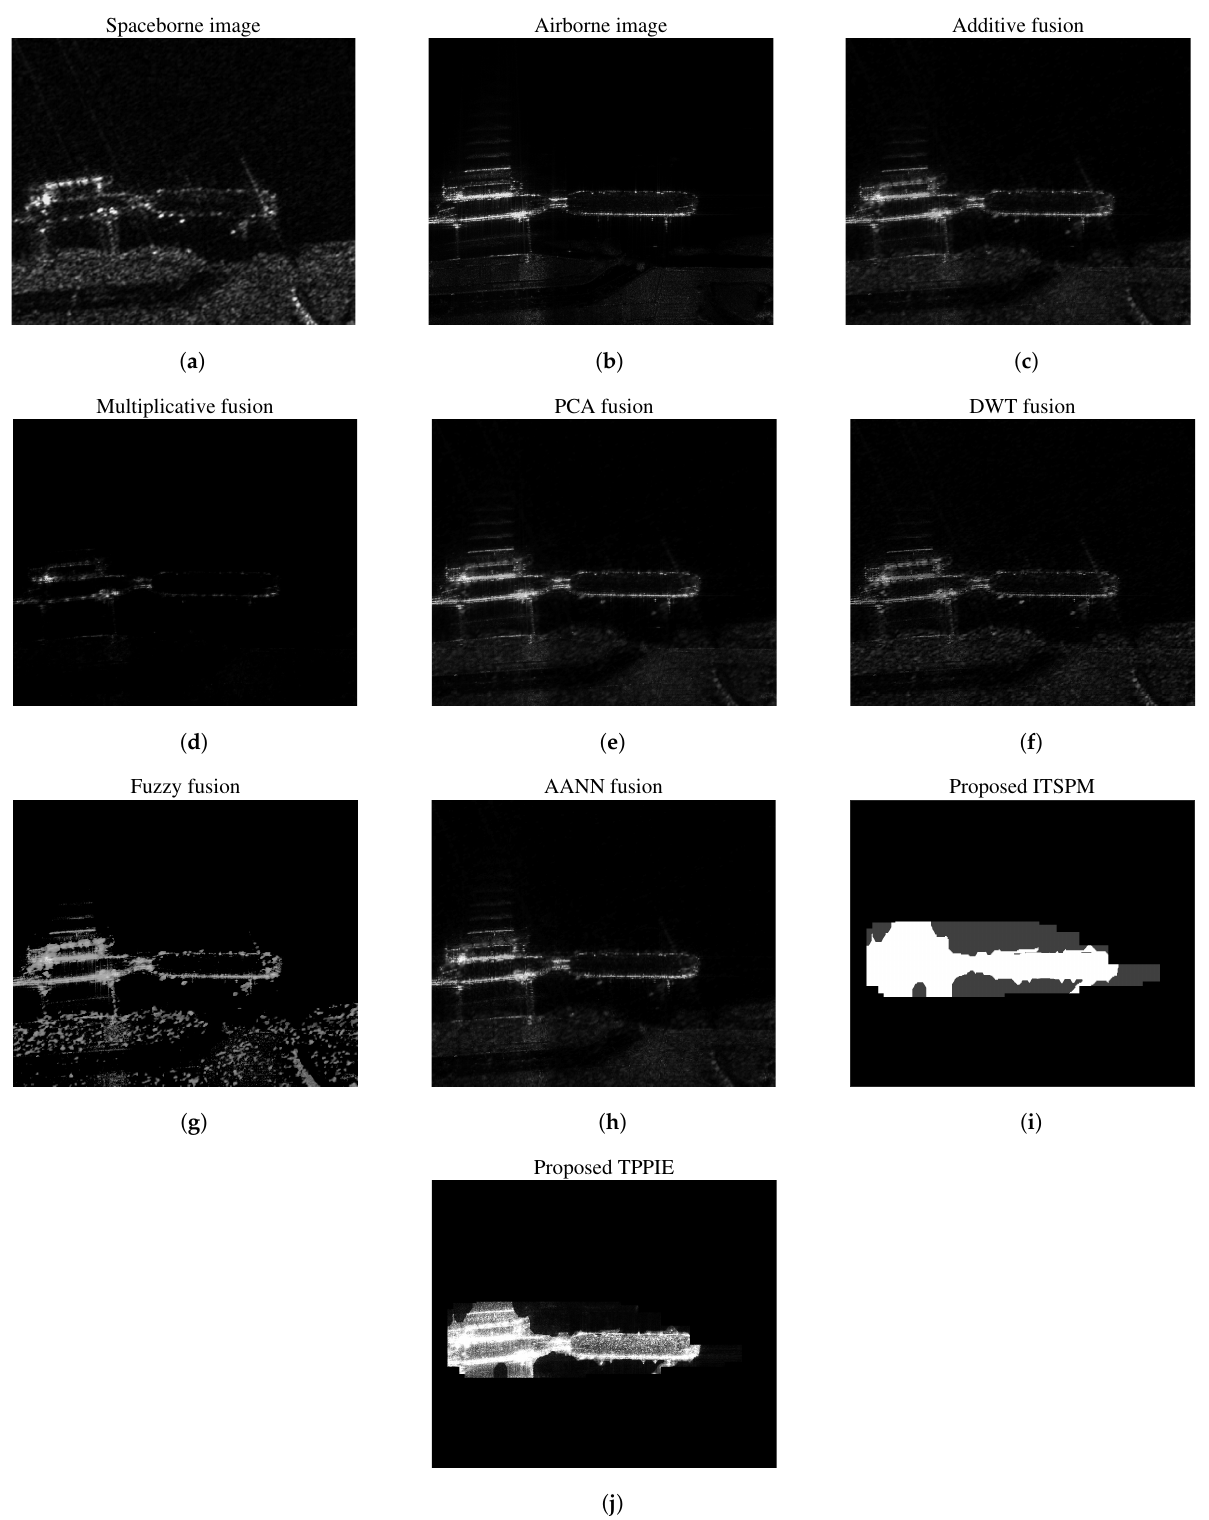
Figure 6. Experimental results for scene 1: ( a ) Spaceborne image; ( b ) airborne image; ( c ) additive fusion [10]; ( d ) multiplica- tive fusion [10]; ( e ) PCA fusion [12]; ( f ) DWT fusion [13]; ( g ) fuzzy fusion [16]; ( h ) AANN fusion [18]; ( i ) proposed ITSPM fusion; and ( j ) proposed TPPIE fusion. The proposed methods can achieve better fused images with enhanced target regions and suppressed background regions, compared to the other image fusion